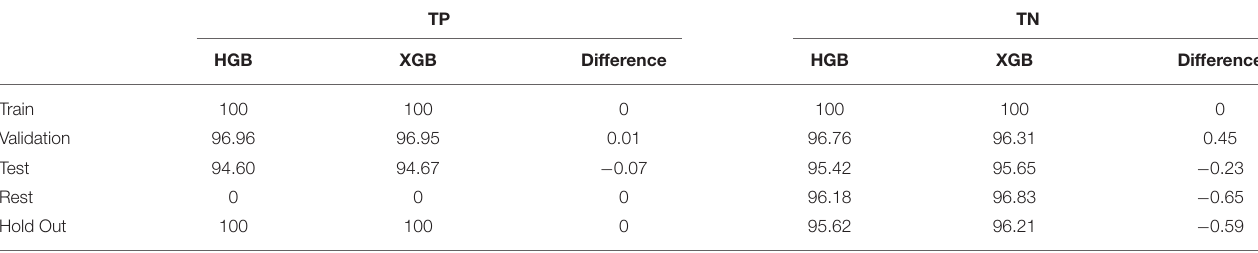
Positive difference values = HGB > XGB, Negative = XGB > HGB.